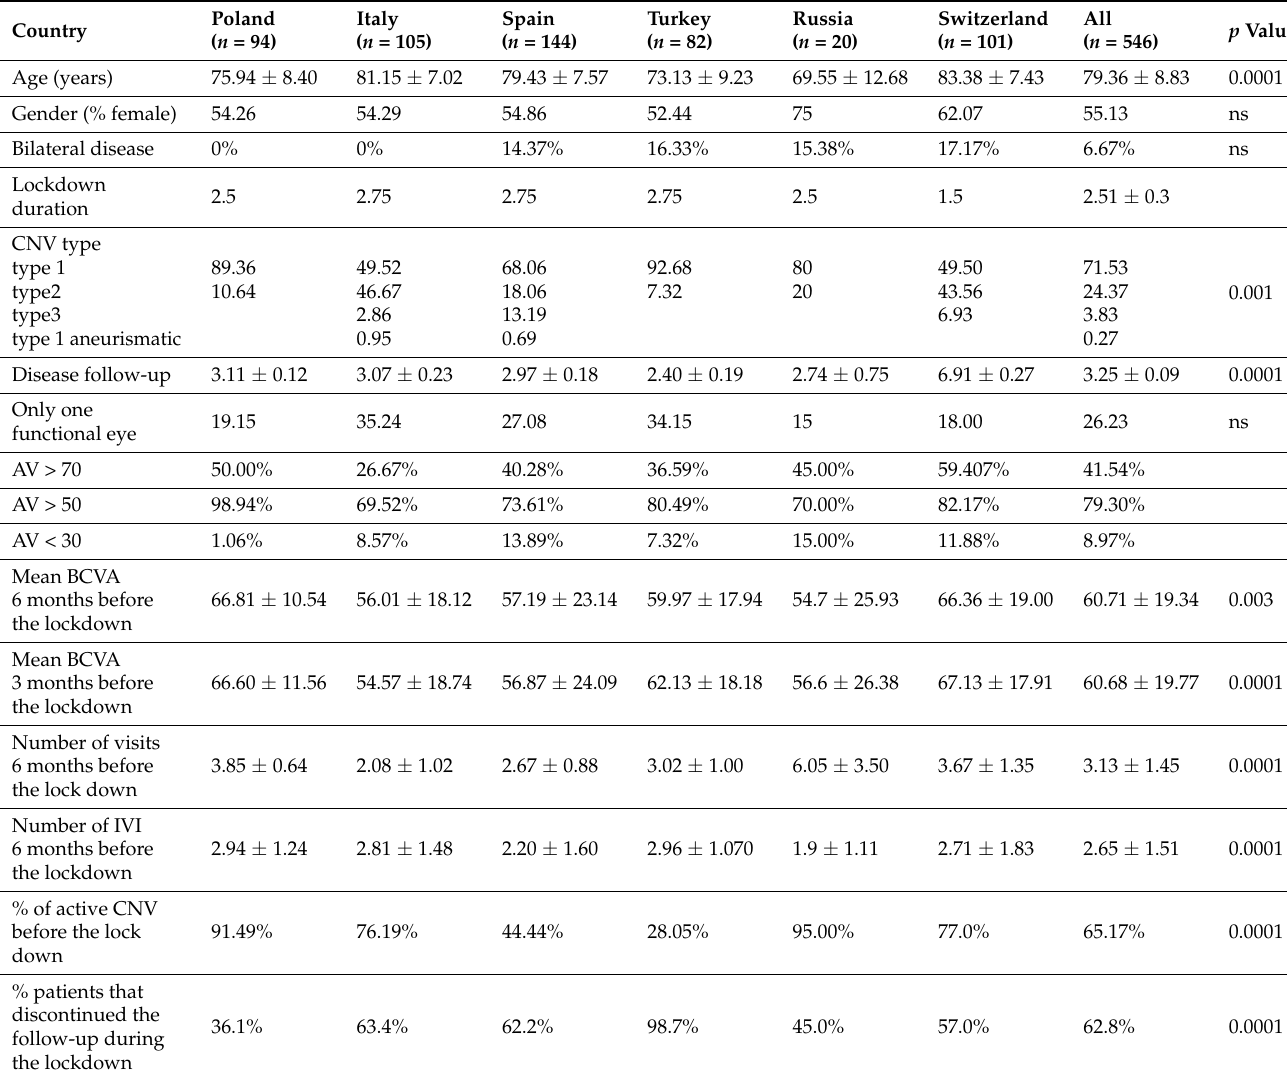
Table 1. Patient